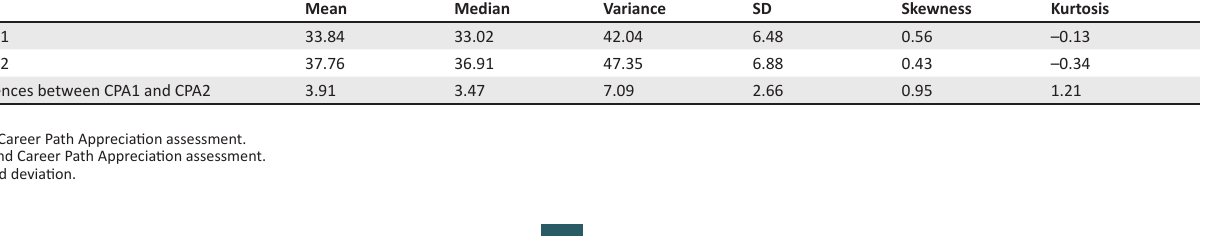
TABLE 1 : Age of participants at the time of the first and second Career Path Appreciation assessments.